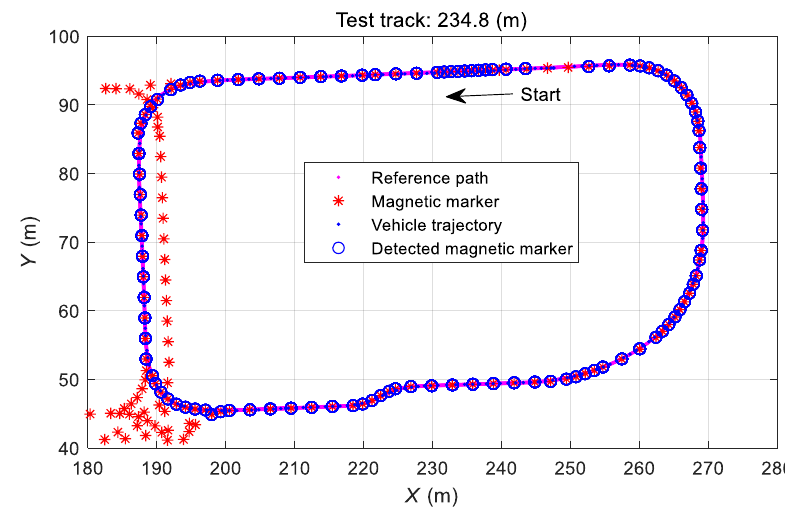
Figure 13. Normal automatic path tracking.